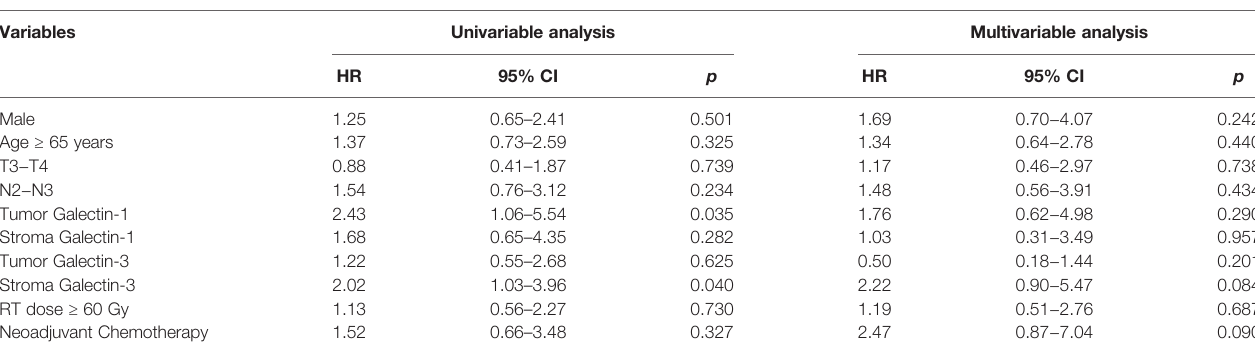
TABLE 4 | Univariable and multivariable Cox regression analyses of DMFS.